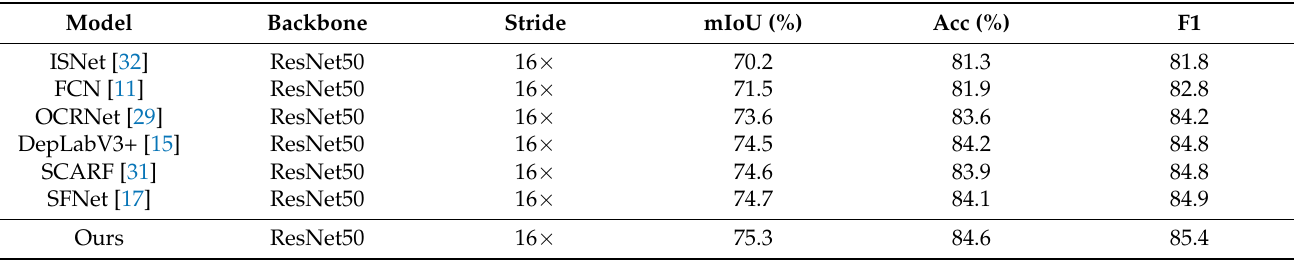
Table A1. Robustness evaluation results on the Potsdam test